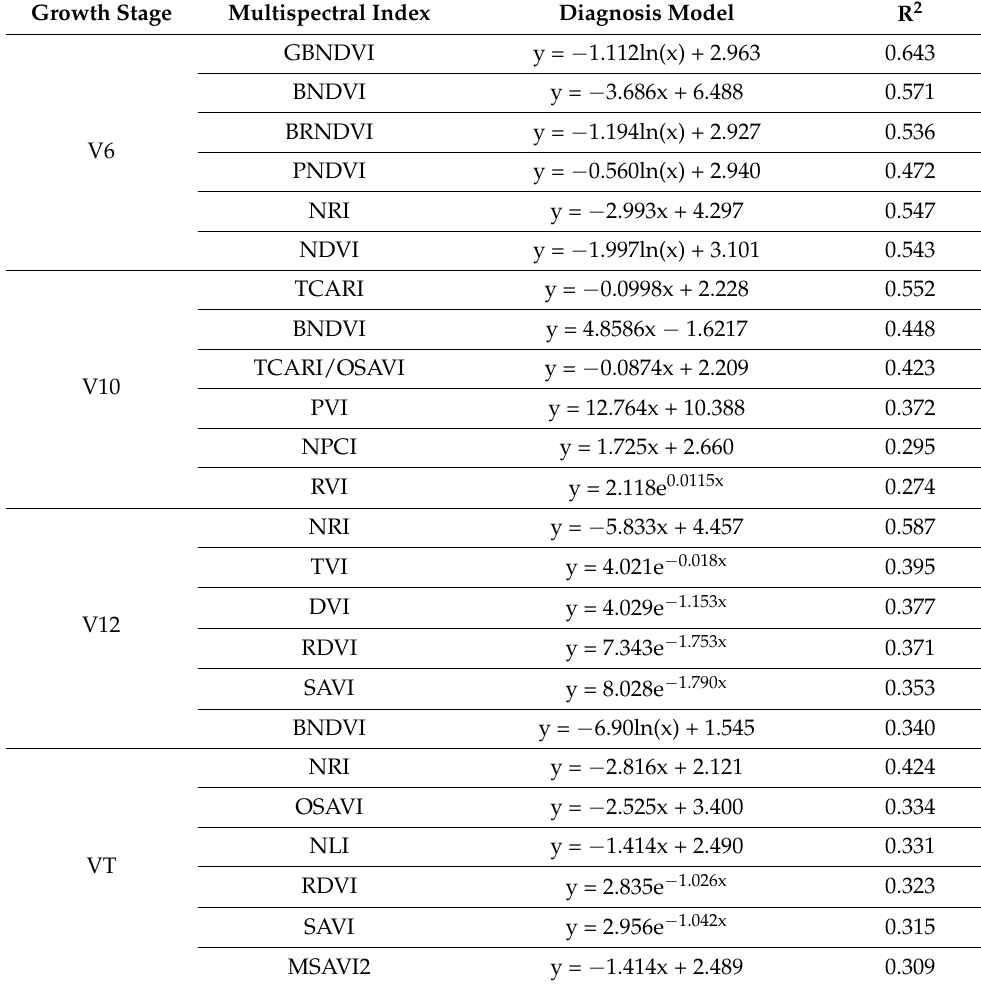
Table 2. Multispectral diagnosis models and evaluation results of the summer maize nitrogen concentration at different growth